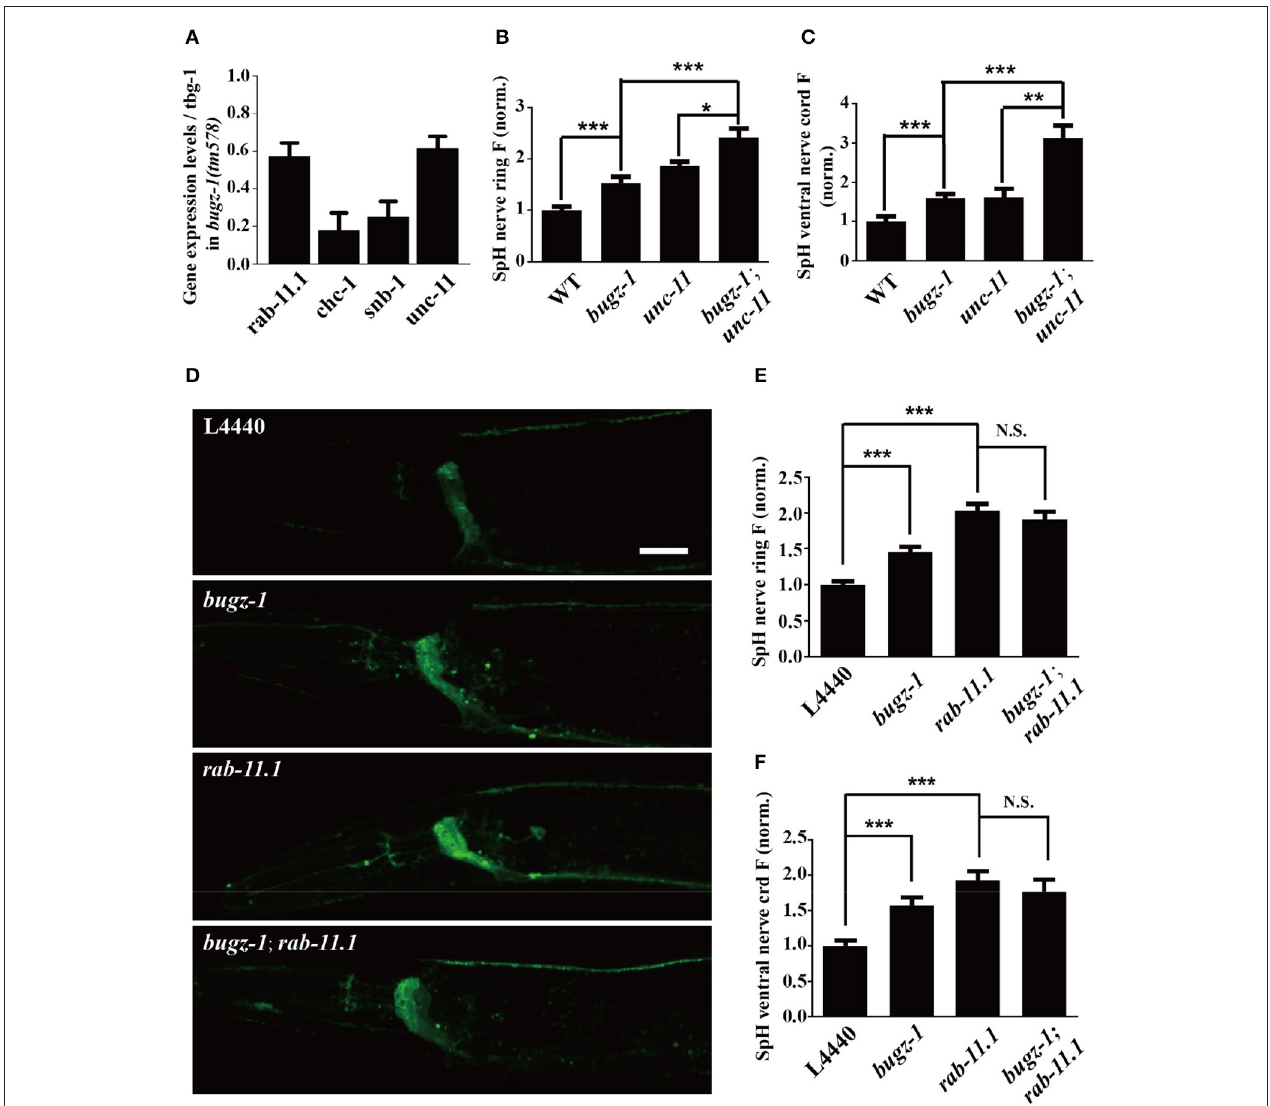
FIGURE 7 | rab-11.1 is a likely direct target of BuGZ-1. (A) qRT-PCR verification of down-regulation of rab-11.1, chc-1 , snb-1 , and unc-11 transcript levels in bugz-1(tm578) mutant relative to wild type. (B,C) Quantification of SpH fluorescence in the nerve ring (B) and ventral nerve cord (C) of N2, bugz-1 , unc-11 , and bugz-1;unc-11 worms. n ≥ 14. (D) Representative confocal images of eri-1(mg366);lin-15b(n744);Is[snb-1::pHluorin] worm treated with L4440, bugz-1 , rab-11.1 , and bugz-1;rab-11.1 RNAi bacteria. Scale bar indicates 10 µ m. (E,F) Quantification of fluorescence in the nerve ring (E) and ventral nerve cord (F) of indicated RNAi treatment which normalized to the L4440 control. n ≥ 14. Values that significantly differ from controls are indicated (* p < 0.05; ** p < 0.01; *** p < 0.001 by two-tails Student’s t -test). N.S. indicates no significant difference between genotypes compared. Error bars represent SEM.